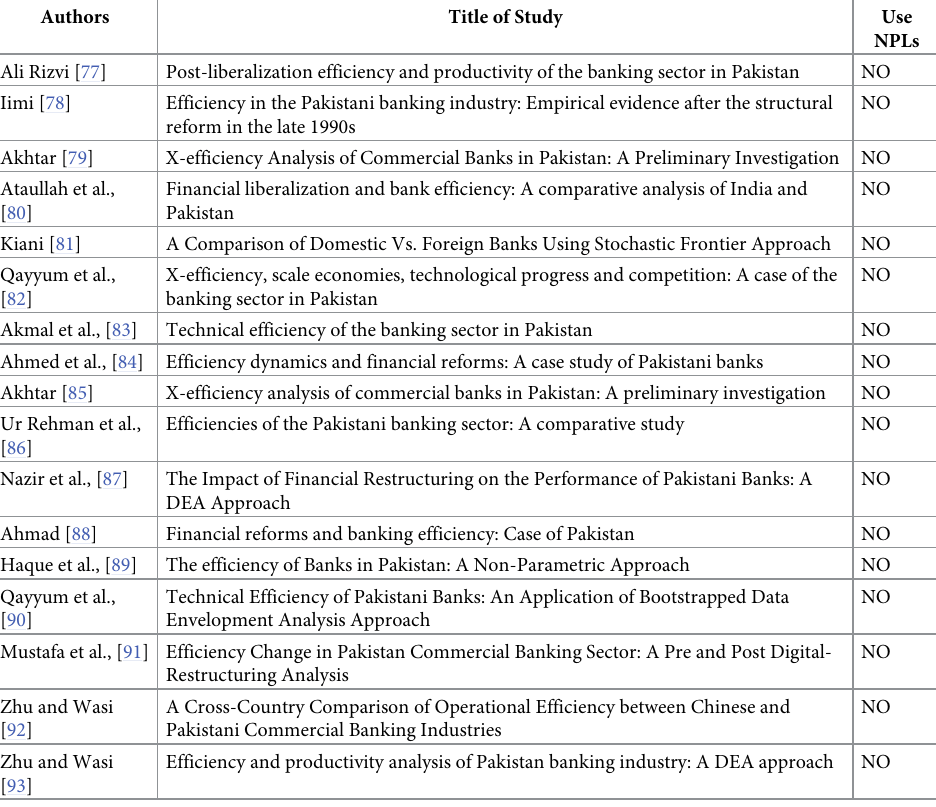
Table 1. Studies employed DEA to measure efficiencies of commercial banks in Pakistan. Authors Title of Study Use